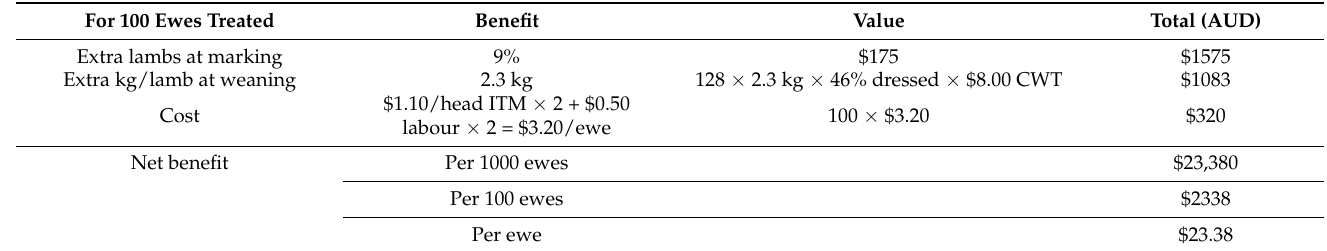
Table 3. Net benefit of using injectable trace minerals pre-joining and pre-lambing in